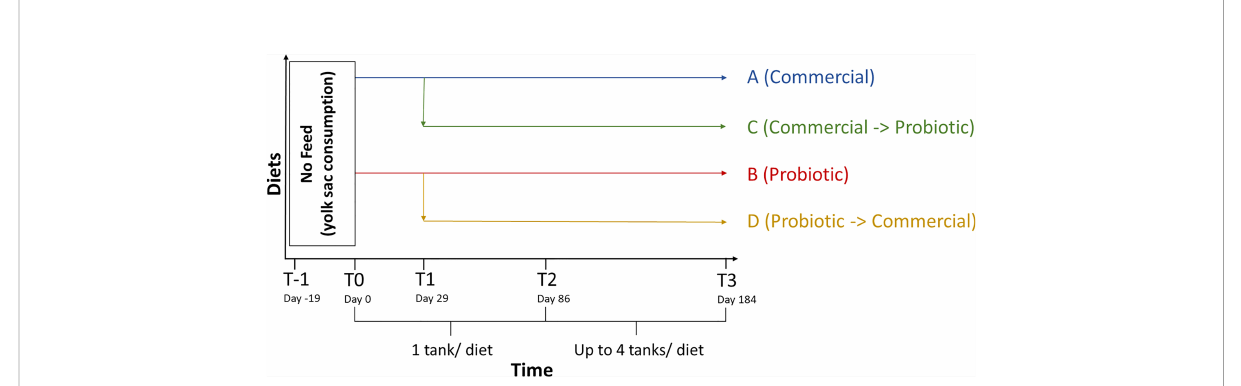
FIGURE 1 Timeline for steelhead trout harvests and feeding schedule. The water column and internal tissues of trout were collected at the indicated timepoints relative to the date of fi rst exogenous feeding (T-1, Day -19; T0, Day 0; T1, Day 29; T2, Day 86; T3, Day 184). Fish were fed one offour diet regimens starting at T0 with the C and D diet groups differentiated at T1. The probiotic concentration for diets B, C, and D was ~10 8